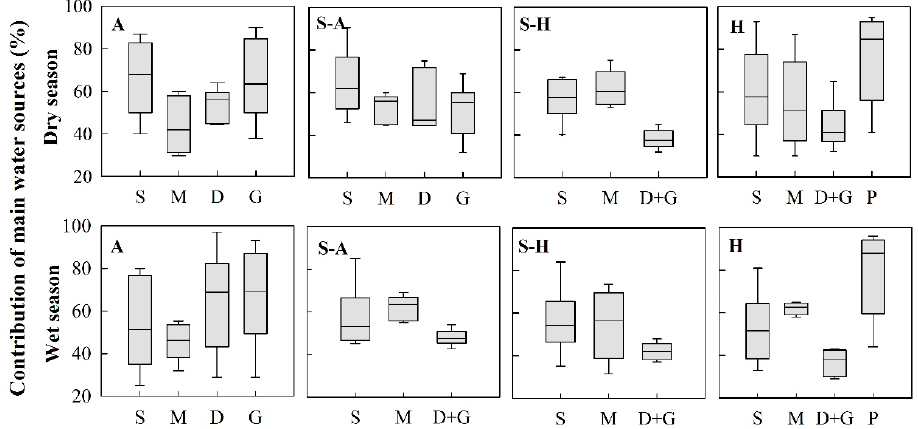
Figure 9. Contribution of the plant main water source. A: Arid region; S-A: Semi-arid region; S-H: Semi-humid region; H: humid region; S: Shallow soil water; M: Middle soil water; D: Deep soil water; G: Groundwater; P: Precipitation; D + G: Combination of deep soil water and groundwater. Deep soil water and groundwater were classified as a group because of the small number of samples for